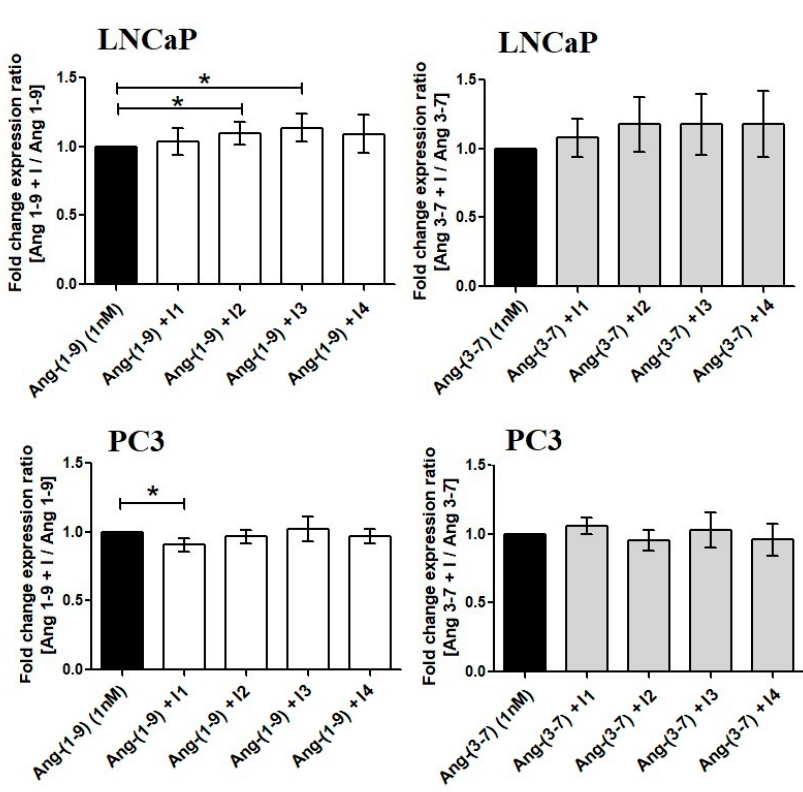
Figure 2. The MTT test results showing the impact of angiotensin receptor inhibitors on Ang-(1-9) and Ang-(3-7) (1 nM) activity in prostate cancer cells: LNCaP, and PC3. (I1: AT1 inhibitor—losartan; I2: AT2 inhibitor—PD123319; I3: AT1–7/MAS inhibitor—A779; I4—AT4/IRAP inhibitor—HFI142; 1000 nM) (Dunnett’s test; * p < 0.05).